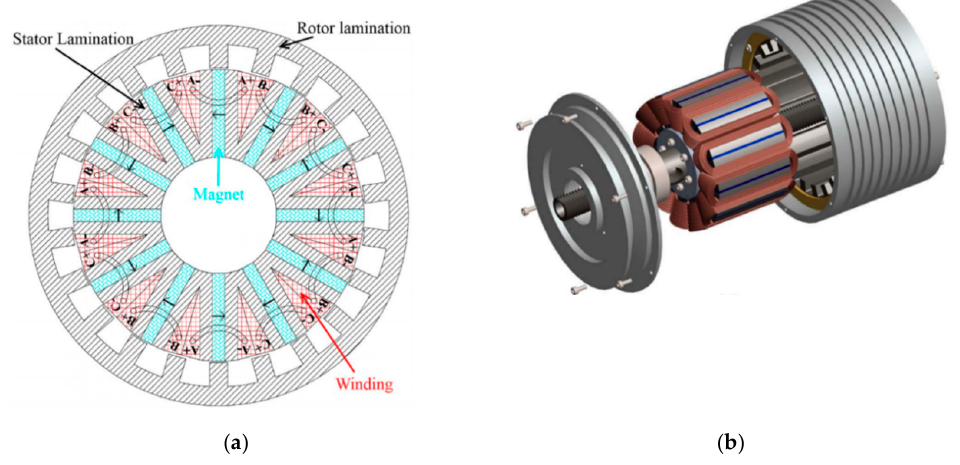
Figure 11. Configuration of a flux-switching PM (FSPM) machine [33].